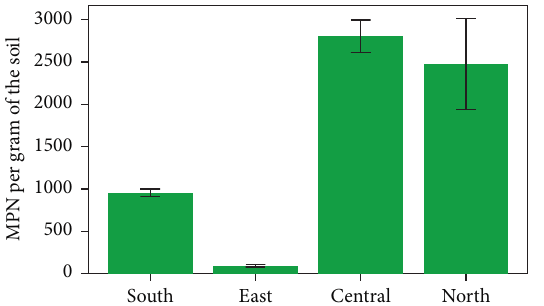
Figure 5: Enumerated most probable numbers of bacteria pop- ulation from four